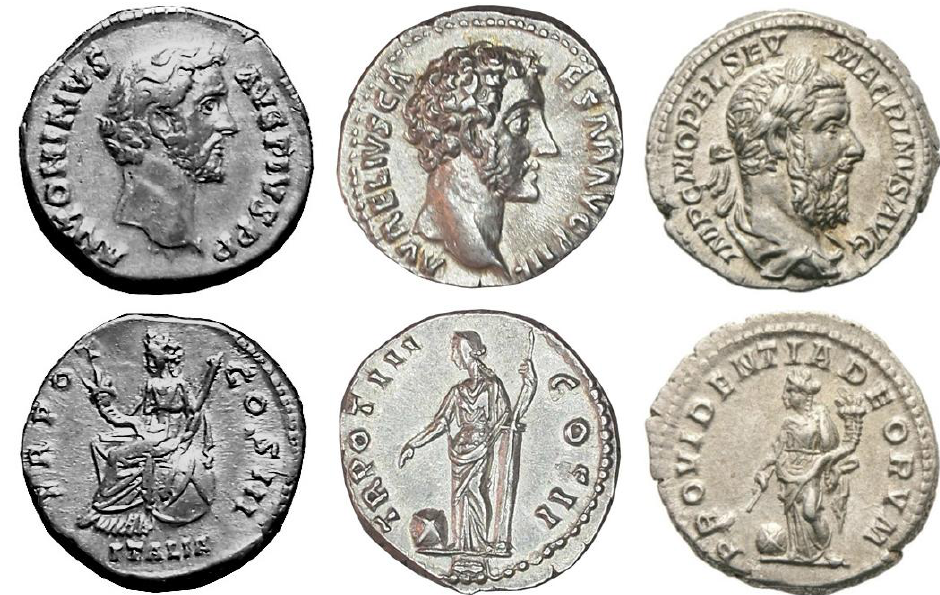
Figure 2. Plato‘s X on Roman coins. Left: Denarius of Antoninus Pius, with Italia enthroned on celestial sphere with intersecting lines ( RIC III [9] #98a). Middle: Coin of Marcus Aurelius, with Providentia pointing to the celestial sphere with intersecting lines ( RIC III [9] (Pius) #446). Right: Coin of Macrinus, with Providentia pointing to cosmic orb with intersecting lines ( RIC IV Pt 2 [10]